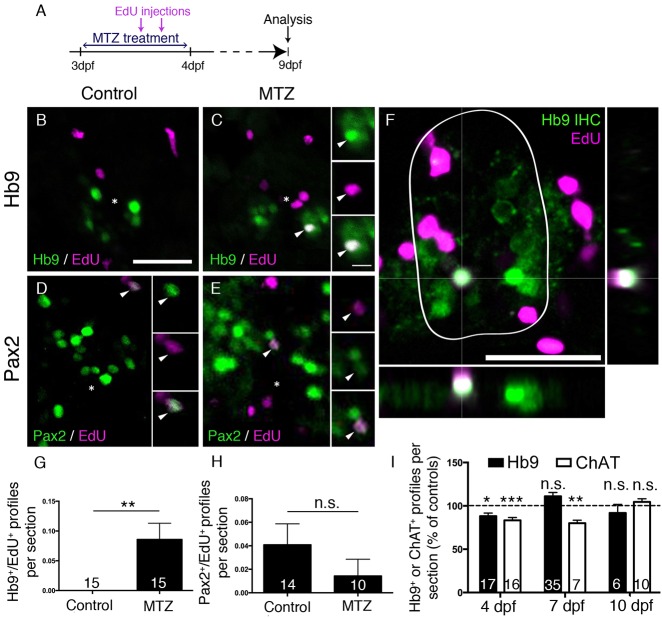
Motor neuron ablation leads to regeneration of motor neurons. (A) Experimental timeline. (B-H) In spinal cross sections, Hb9+/EdU+ motor neurons are only observed in MTZ-treated larvae (B,C, shown in a whole cross section of the spinal cord including orthogonal views in F), whereas Pax2+ interneurons are labelled by EdU in untreated and MTZ-treated larvae, quantified in G (Mann–Whitney U-test, **P=0.0063) and H (Mann–Whitney U-test, P>0.99), respectively. (I) Overall numbers of Hb9+ and ChAT+ profiles are reduced after a lesion, but return to control values at 7 dpf (Hb9 only) or 10 dpf (ChAT) (t-test, *P=0.0188; **P=0.0012; ***P=0.0004). Values are means±s.e.m. Scale bars: 25 µm in B for B-E; 5 µm in inset in C for all insets; 25 µm in F.